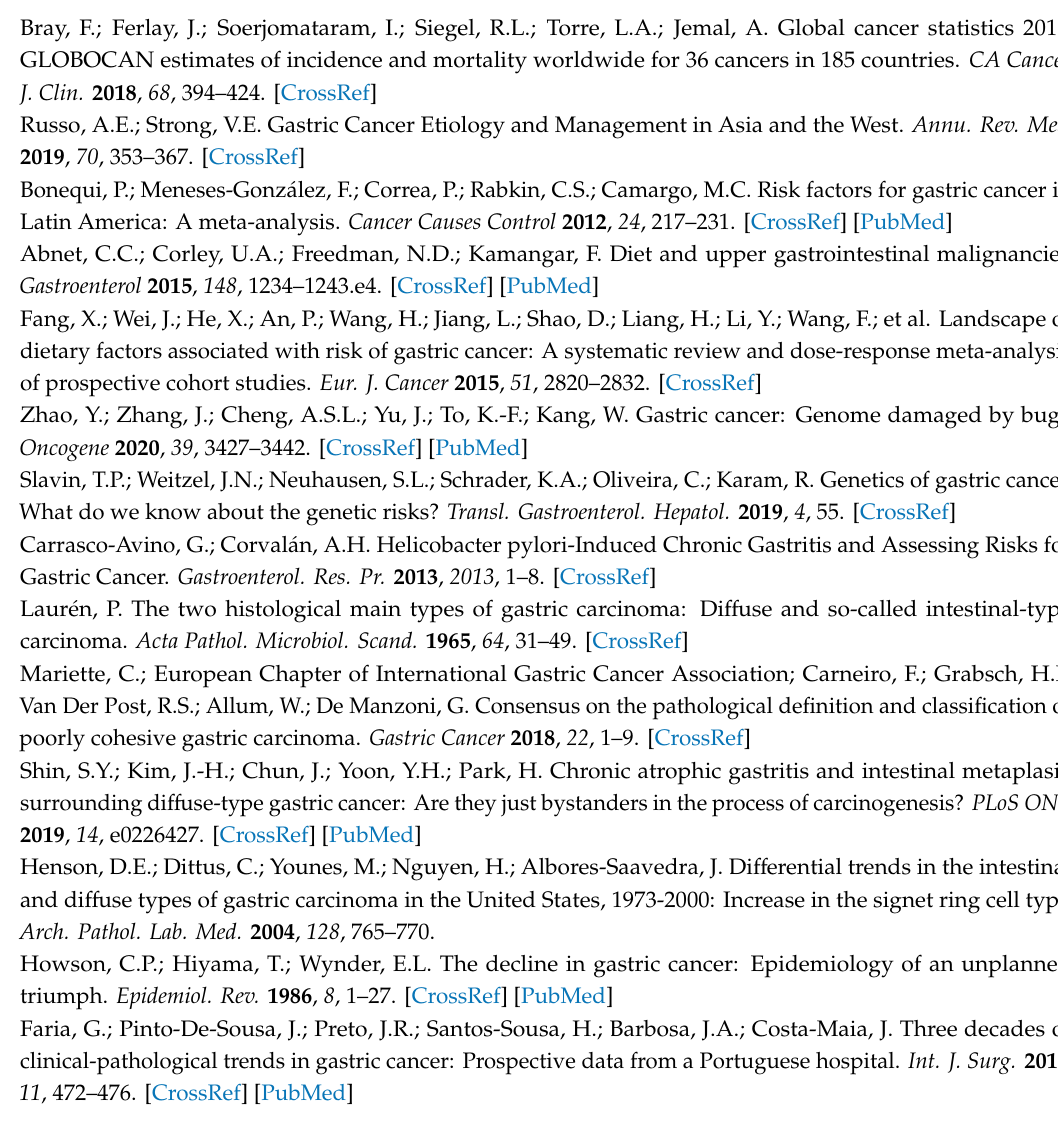
Table S1: Predicted and validated ceRNA networks based on complementary sequences between lncRNAs, miRNAs and mRNAs associated with EMT